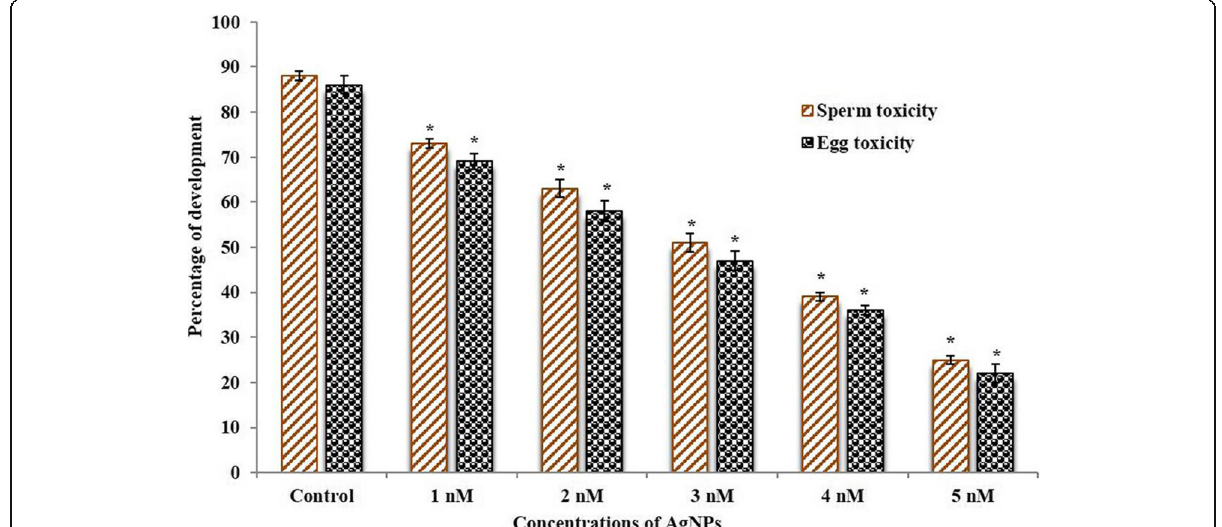
Fig. 4 Effect of silver nanoparticles on sperm and egg of Hydroides elegans . The mean difference is significant when compared to control (* P < 0.05